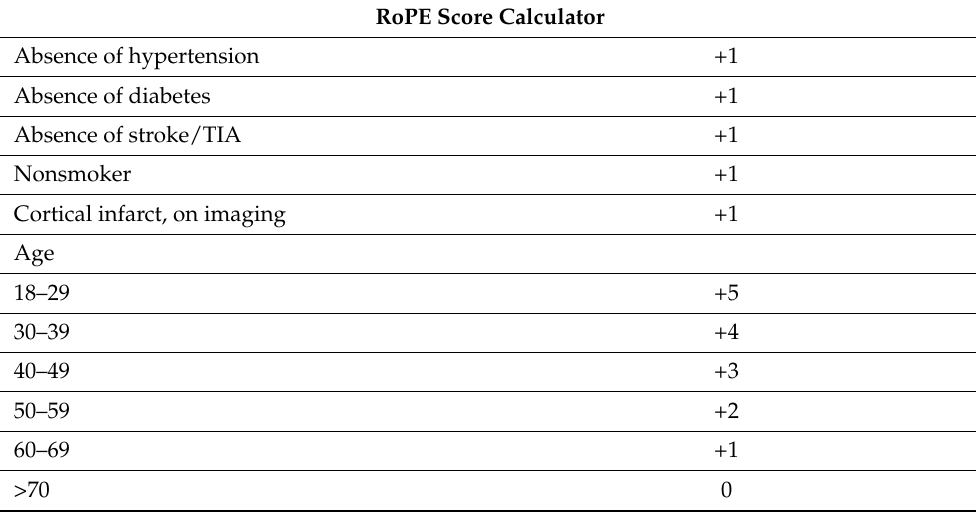
Table 1. RoPE score calculator (adapted by Kent et al., 2013).